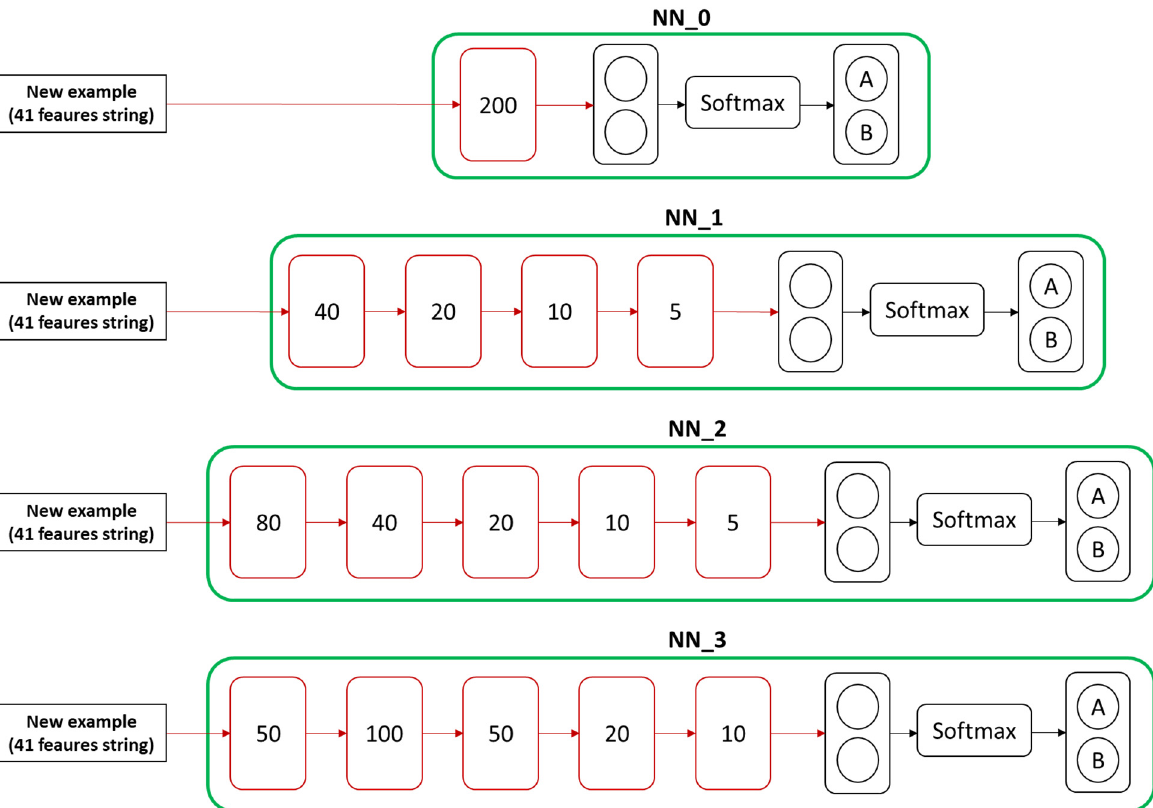
Figure 11. Different artificial neural networks